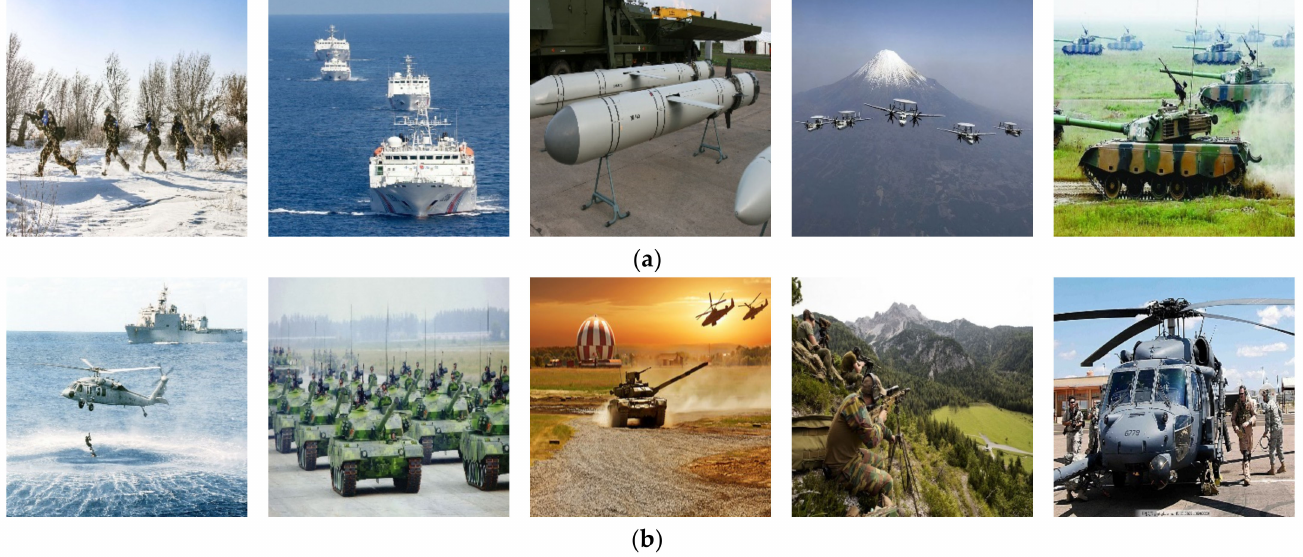
Figure 1. Sample images in MITD. ( a ) A picture contains a single military target; ( b ) A picture contains multiple military